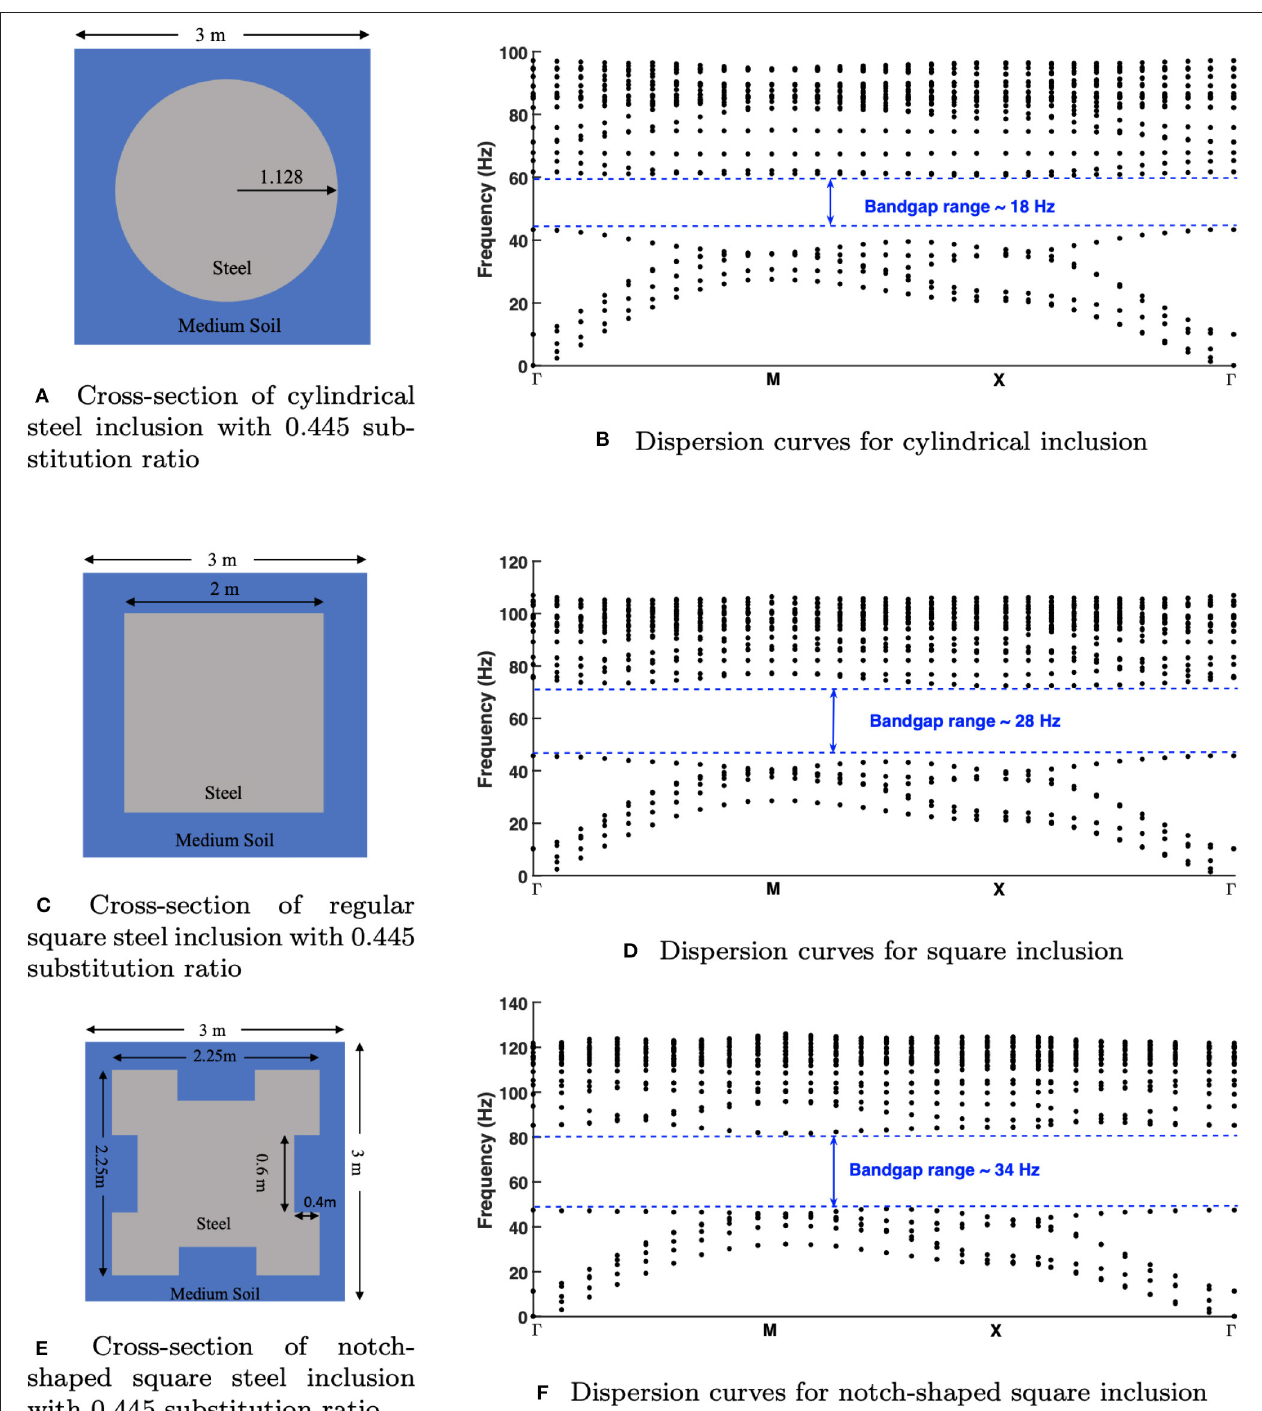
FIGURE 3 | Unclamped configuration of (A) cylindrical ( r = 1.128 m, h = 10 m), (C) regular-shaped square (2 × 2 × 10 m) and (E) notch-shaped square geometry inclusions in the elementary cell (3 × 3 × 10 m) of periodic media (medium soil) with equal substitution ratio (0.445). Dispersion curves for (B) cylindrical (D) regular-shaped square, and (F) notch-shaped square inclusions are obtained around the edges of the irreducible Brillouin zone Ŵ XM . Note that there is an enhanced bandgap range with regular-shaped square ( ∼ 28 Hz) and notch-shaped square ( ∼ 34 Hz) inclusions in comparison to cylindrical inclusion ( ∼ 18 Hz).